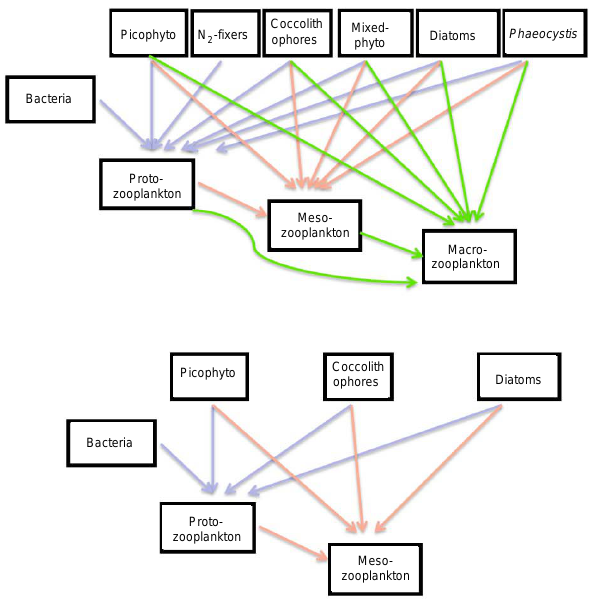
Figure 1. Schematic representation of the PlankTOM10 (top) and PlankTOM6 (bottom) marine ecosystem models. The arrows show grazing fluxes by protozooplankton (purple), mesozooplank- ton (red), and macrozooplankton (green). Only fluxes with weigh- ing factors above 0.1 are shown (Table